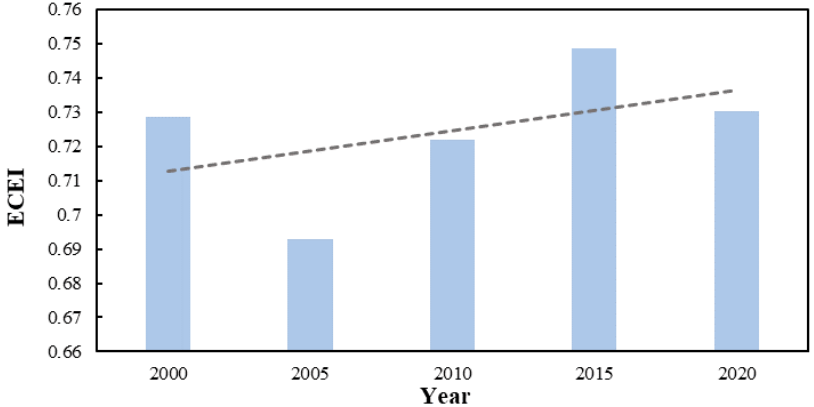
Figure 3. Average ECEI values of Zhaotong from 2000 to 2020.